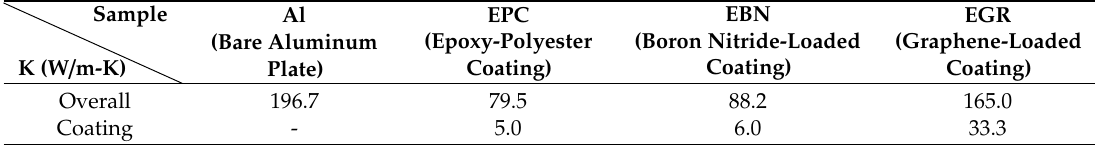
Table 5. Thermal conductivity of the aluminum plates with or without coating *. m-K)Sample K (W /